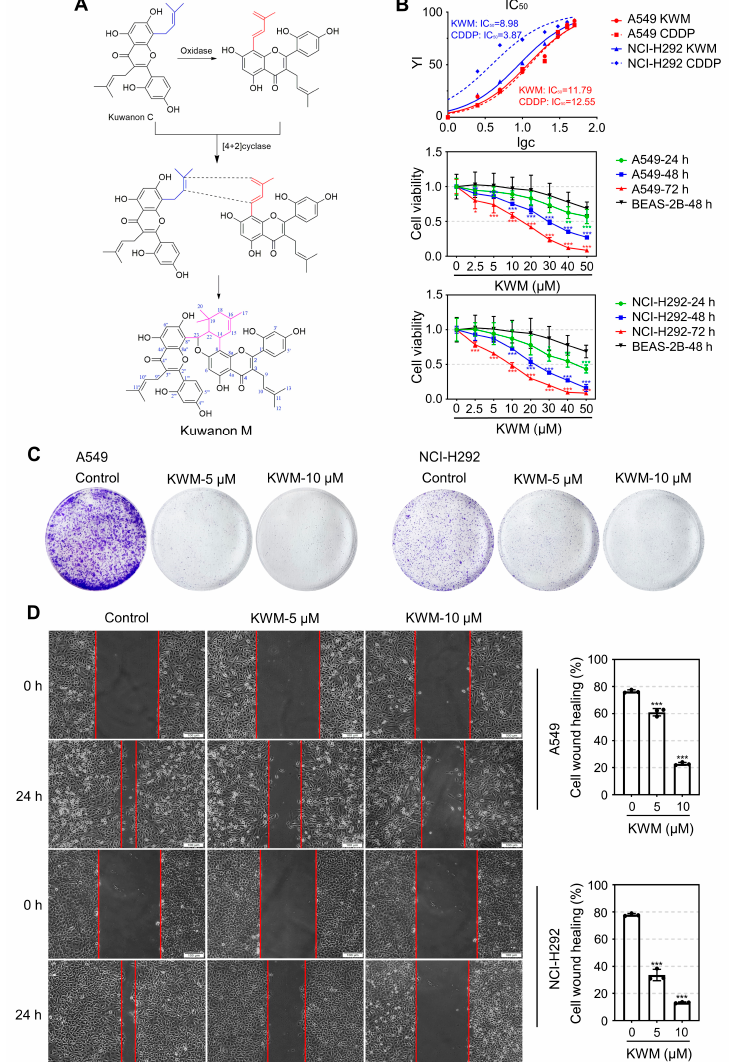
Figure 1. KWM suppressed the proliferation, colony formation and migration of NSCLC cells. ( A ) The chemical structure of KWM. ( B ) BEAS-2B, A549 and NCI-H292 cells were exposed to KWM with indicated concentrations for 24, 48 and 72 h, cell viability was detected by MTT assay, cisplatin was used as positive control. ( C ) Inhibition of colony formation in A549 and NCI-H292 cells treated by KWM. ( D ) Cells were treated with the indicated doses of KWM, scratch wound assay was performed after treatment. Images were captured by optical microscopy. Data were expressed as mean ± SD, n = 3. *** p < 0.001 versus control